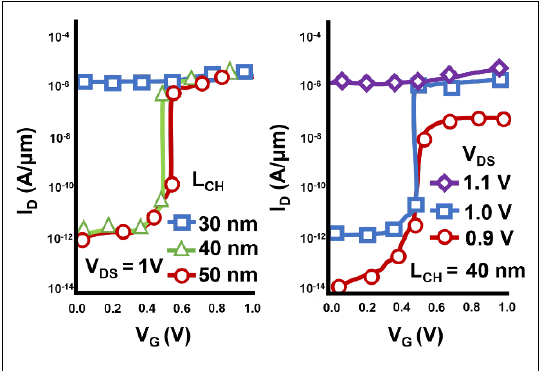
Figure 7. I D -V G curve for 30–50 nm channel lengths when 1 V is applied to the drain ( left ), and for a 0.9–1.1 V drain bias with an L CH of 40 nm ( right )